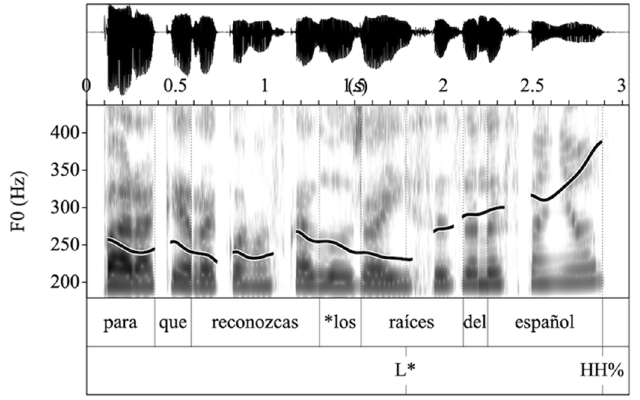
Figure 7. Example of an early rise produced by a heritage speaker. para que reconozcas *los raíces del español ‘so that you recognize the roots of Spanish’.